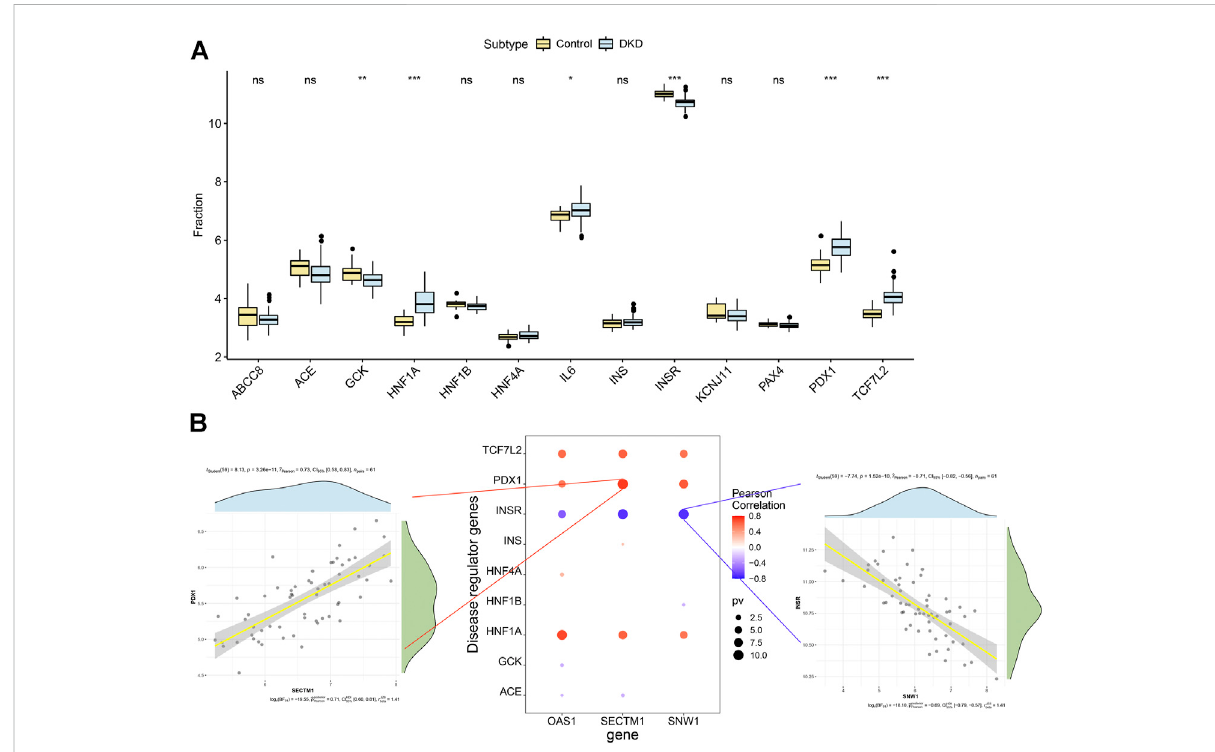
FIGURE 9 Correlation analysisofDKD-regulated genes. (A) DifferencesintheexpressionofDKD-regulated genesincontrolpatients(yellow)andpatients with DKD (blue). (B) Pearson correlation analysis of DKD-regulated and core genes. Blue and red indicate negative and positive correlations,